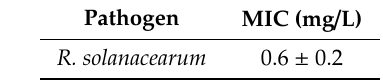
Table 2. Minimum inhibitory concentration (MIC) values of actinomycin D against R. solanacearum.